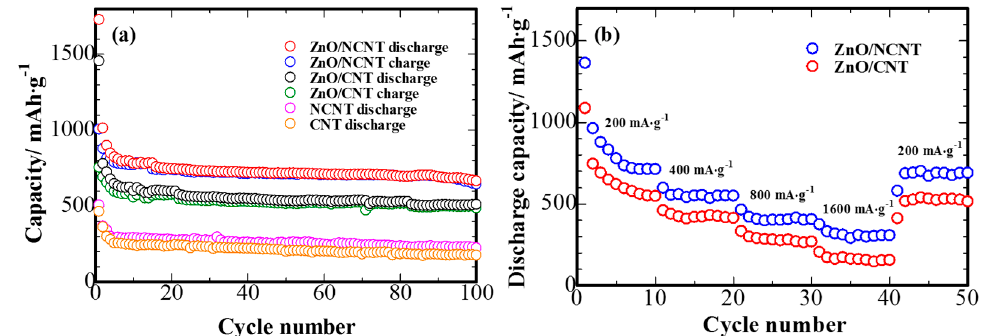
Figure 4. ( a ) Cycling performance of the CNT, NCNT, ZnO/NCNT, and ZnO/CNT anodes at a current density of 100 mA·g − 1 ; ( b ) Rate capability of the ZnO/NCNT and ZnO/CNT composite anodes at density of 100 mA · g − 1 ; ( b ) Rate capability of the ZnO/NCNT and ZnO/CNT composite anodes at different current densities from 200 to 1600 mA·g − 1 . different current densities from 200 to 1600 mA · g − 1